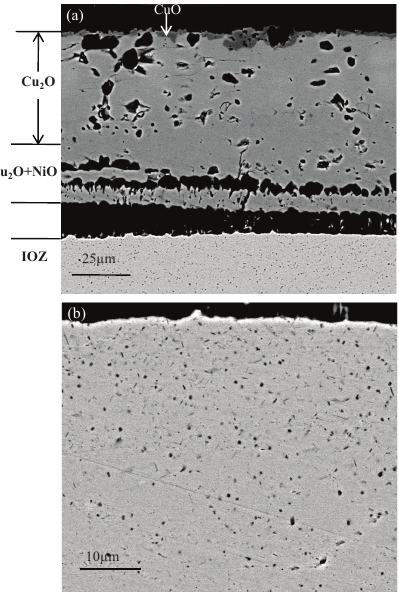
Figure 3. BEI micrographs of a cross section of Cu-0.6Ni oxidized at 800 °C in 1 atm O 2 for 30 min. (a) General view; (b) Enlarged view of the IOZ.